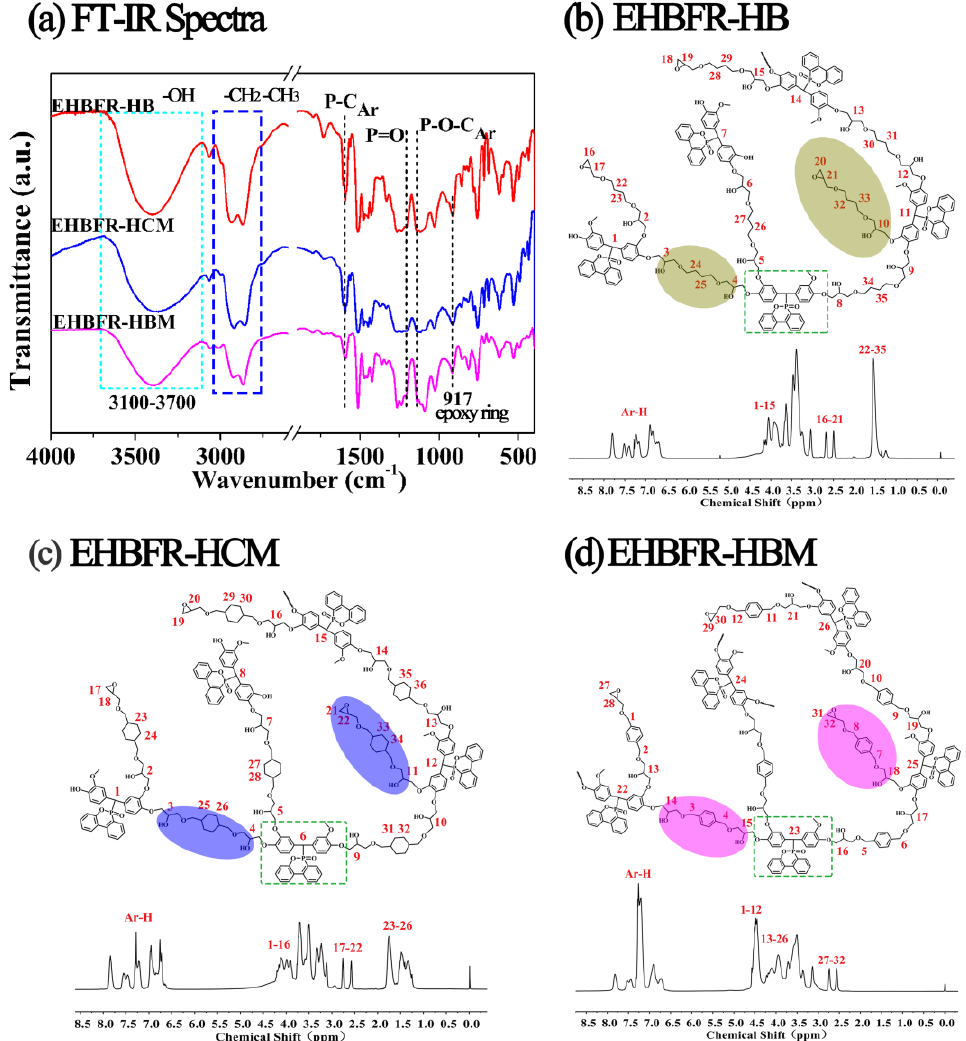
Figure 1. FT-IR spectra of EHBFR-HB, EHBFR-HCM, and EHBFR-HBM ( a ) and 1 H NMR spectra of EHBFR-HB ( b ), EHBFR-HCM ( c ), and EHBFR-HBM ( d ).